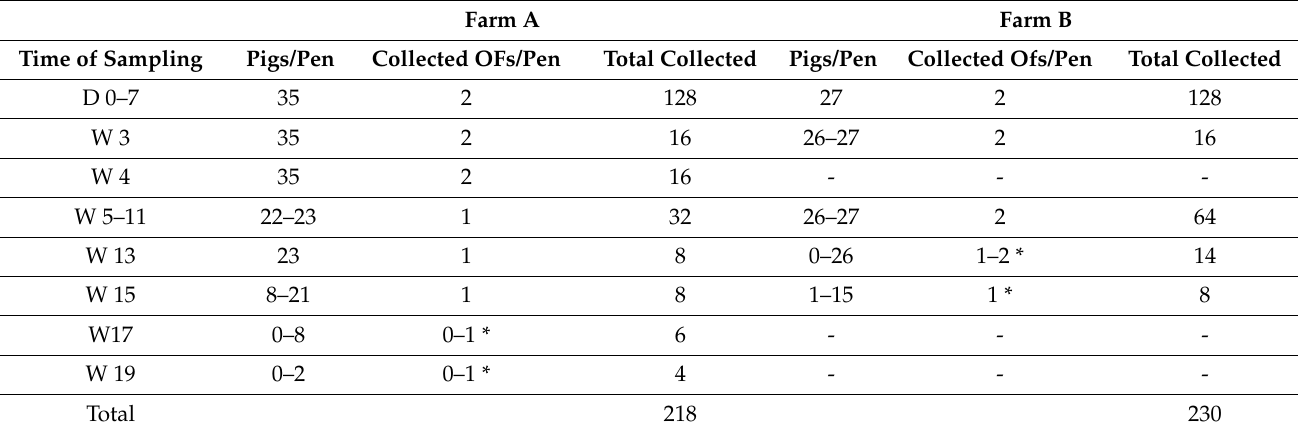
Table 1. Number of collected OFs per sampling time point for each pen and total collected